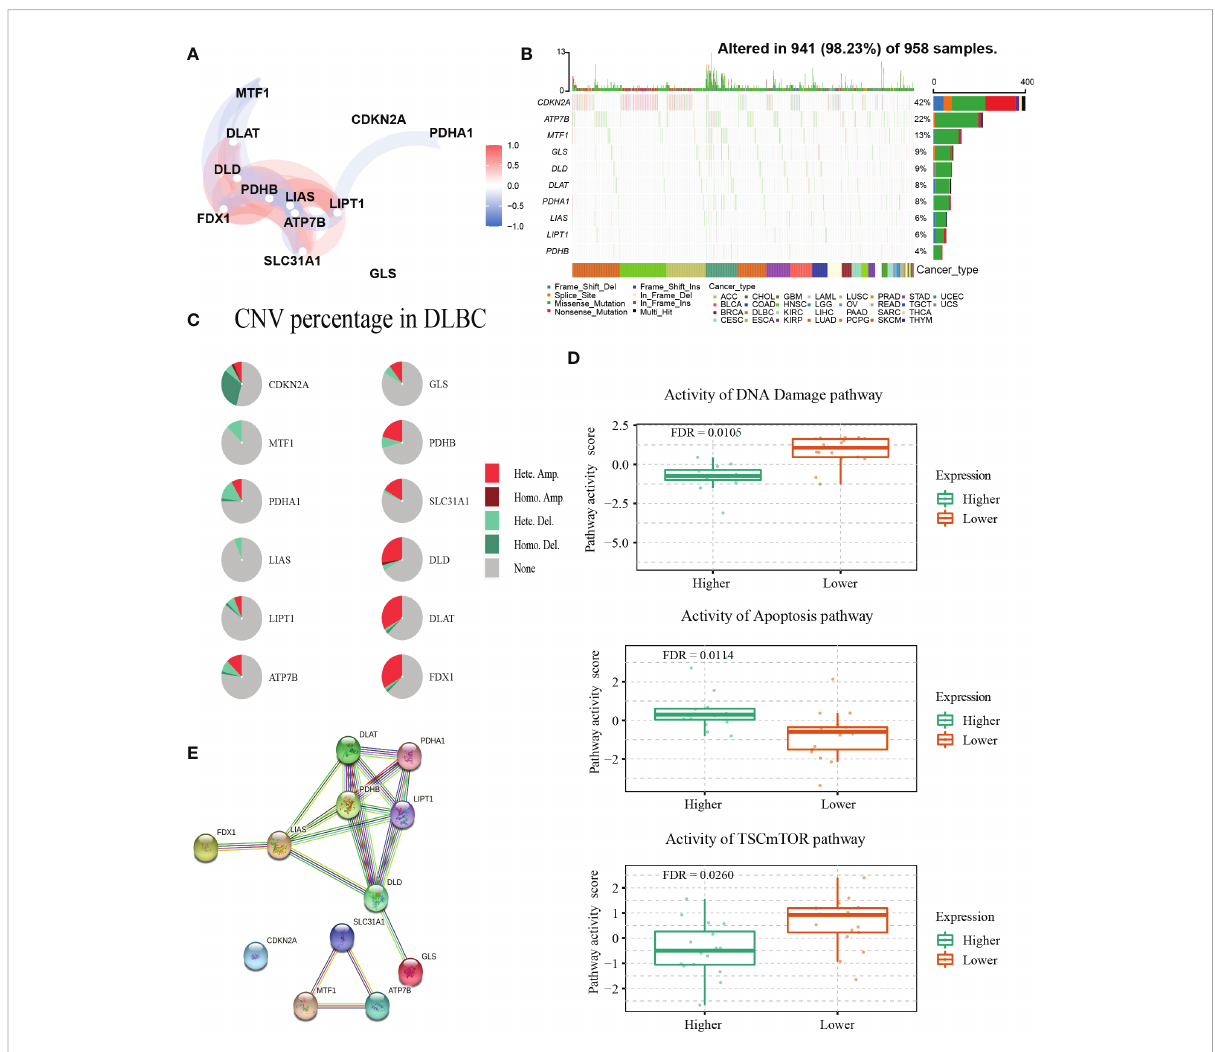
FIGURE 1 Genetic alterations and interactions of CRGs in DLBCL. (A) The correlation network of 12 CRGs. The correlation coef fi cients are represented by different colors. (B) The tumor mutation burden frequency of CRGs in pan-cancer analysis. (C) The CNV percentage of 12 CRGs in DLBCL. (D) The associations between expression of SLC31A1 and activity of DNA damage and apoptosis pathway and the relationship between CDKN2A expression and mTOR pathway activity in DLBCL. (E) The PPI network encoded by CRGs in DLBCL. CNV, copy number variation; PPI, protein- protein